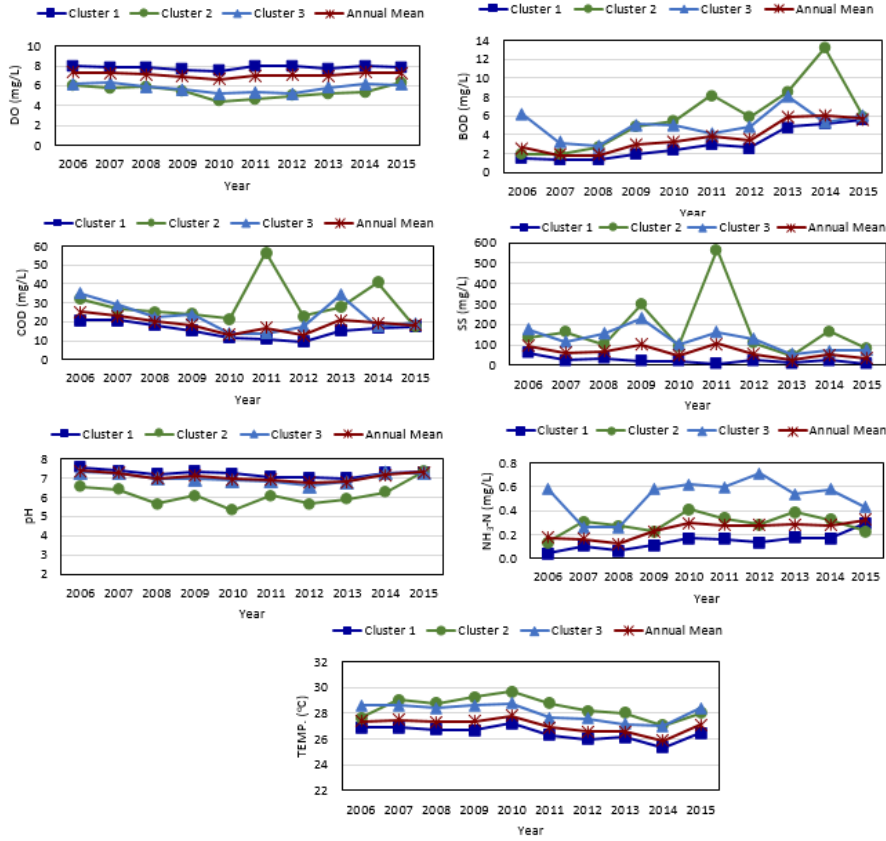
Fig. 4: Time series of water quality variables within the station clusters over 10 years